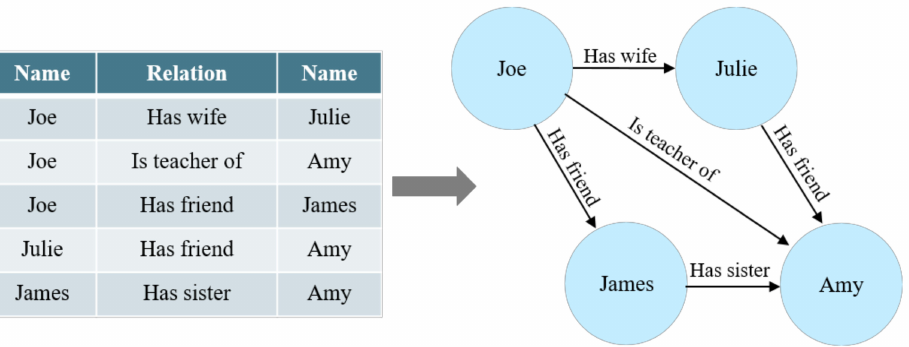
Figure 1. An example of a knowledge